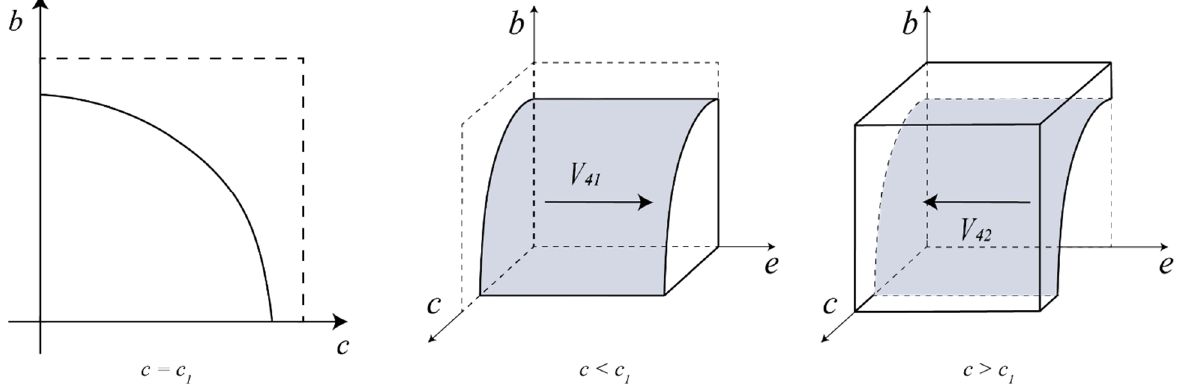
Figure 6. Strategy selection phase diagram of the government.